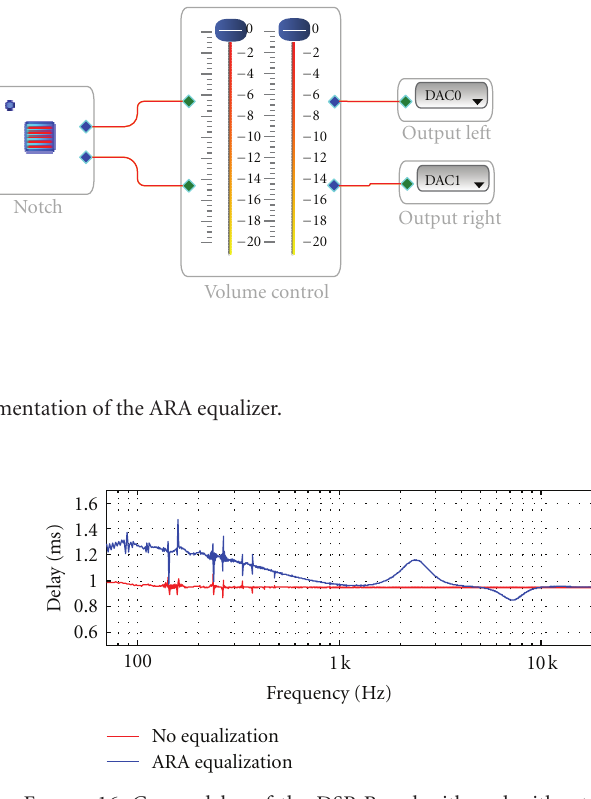
Figure 16: Group delay of the DSP Board with and without the ARA